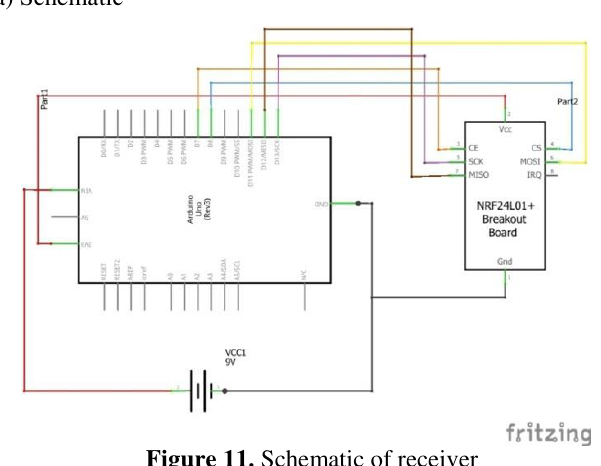
Figure 11. Schematic of receiver